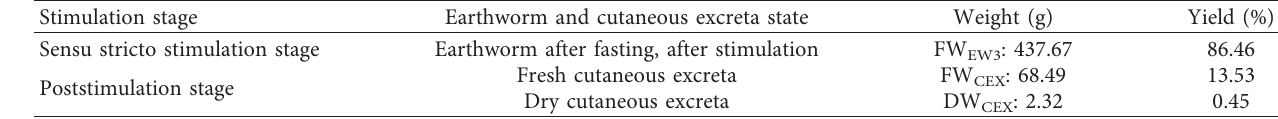
Table 2: Variations in fresh weight and yields during and after